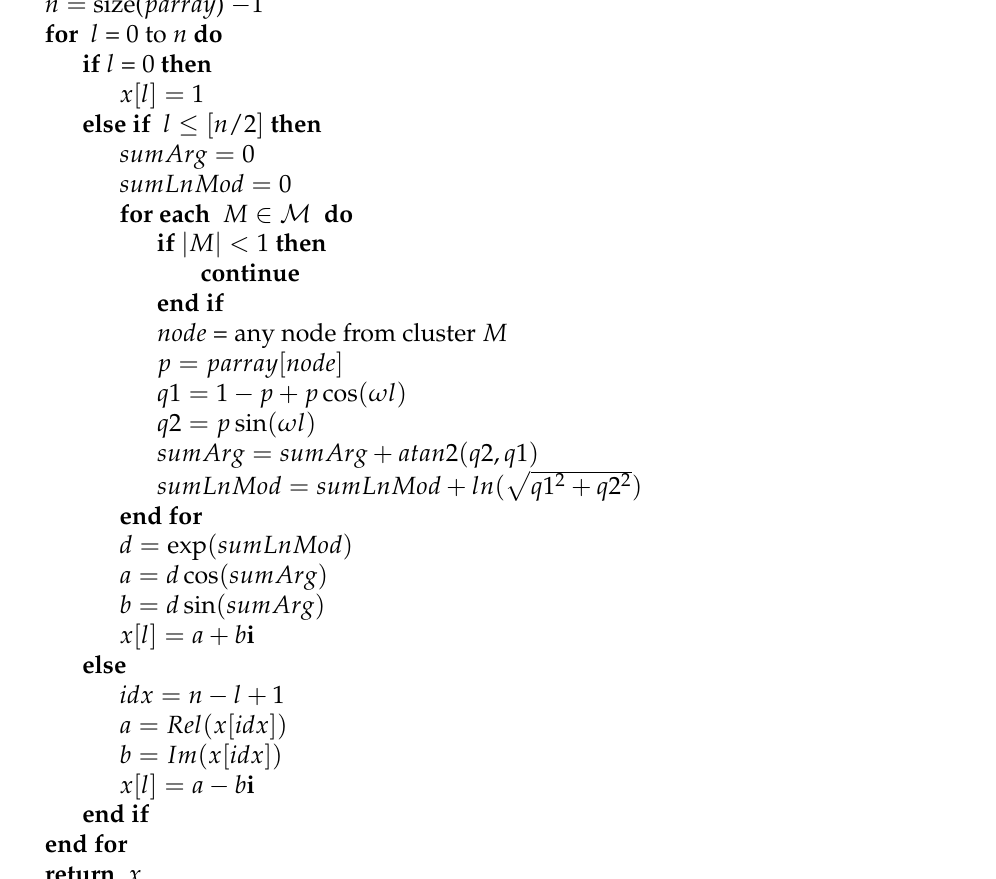
Algorithm 3 compute_x_vector( parray , M = { M 1 , . . . , M m }